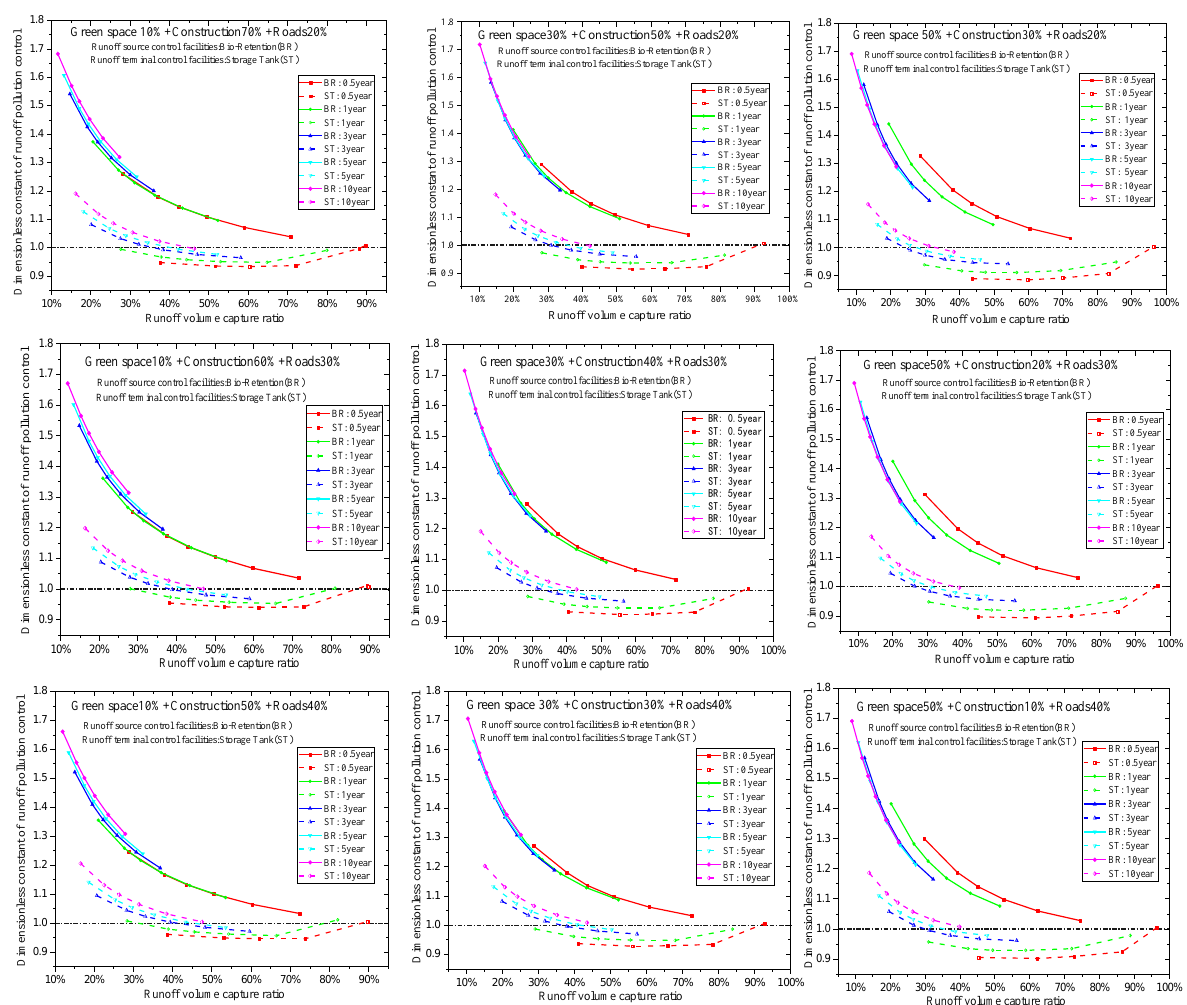
Figure 8. Comparison of runoff pollution control effects between source facilities and terminal facilities under different underlying surface types.